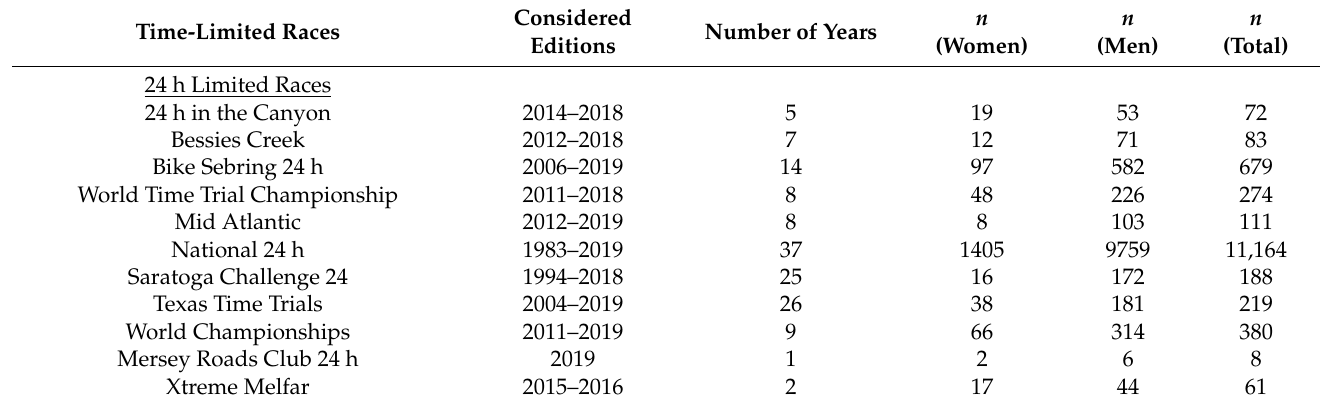
Figure 2. Average speed (km/h) of men and women ( A ). Average speed (km/h) of men ( B ) and women ( C ) subdivided into 6, 12, and 24 h races and age groups. Data expressed as mean and stand- ard deviation. * difference between men and women for each distance below the line. ** difference between race distances for each age group below the line.